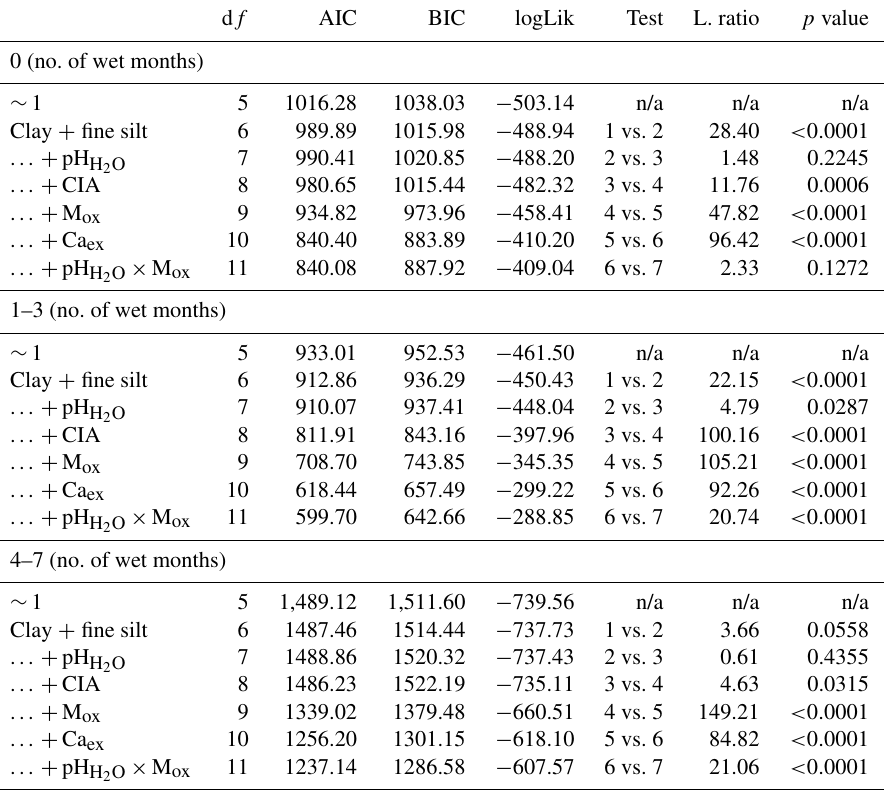
Table B7. ANOVA summary for linear mixed-effects grouped by the number of wet months (P / PET > 1; n 0 = 572, n 1 − 3 = 367, n 4 − 7 = 662). Fixed effects were added using a step-wise method. The first entry ( ∼ 1) refers to the constant null model,